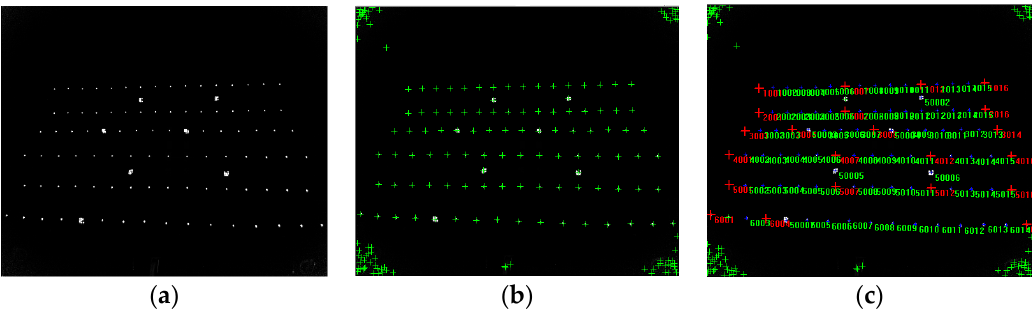
Figure 9. Image captured in 3D control field ( a ); ( b ) reflective targets of infrared image were identified; ( c ) reflective targets of infrared image were registered.